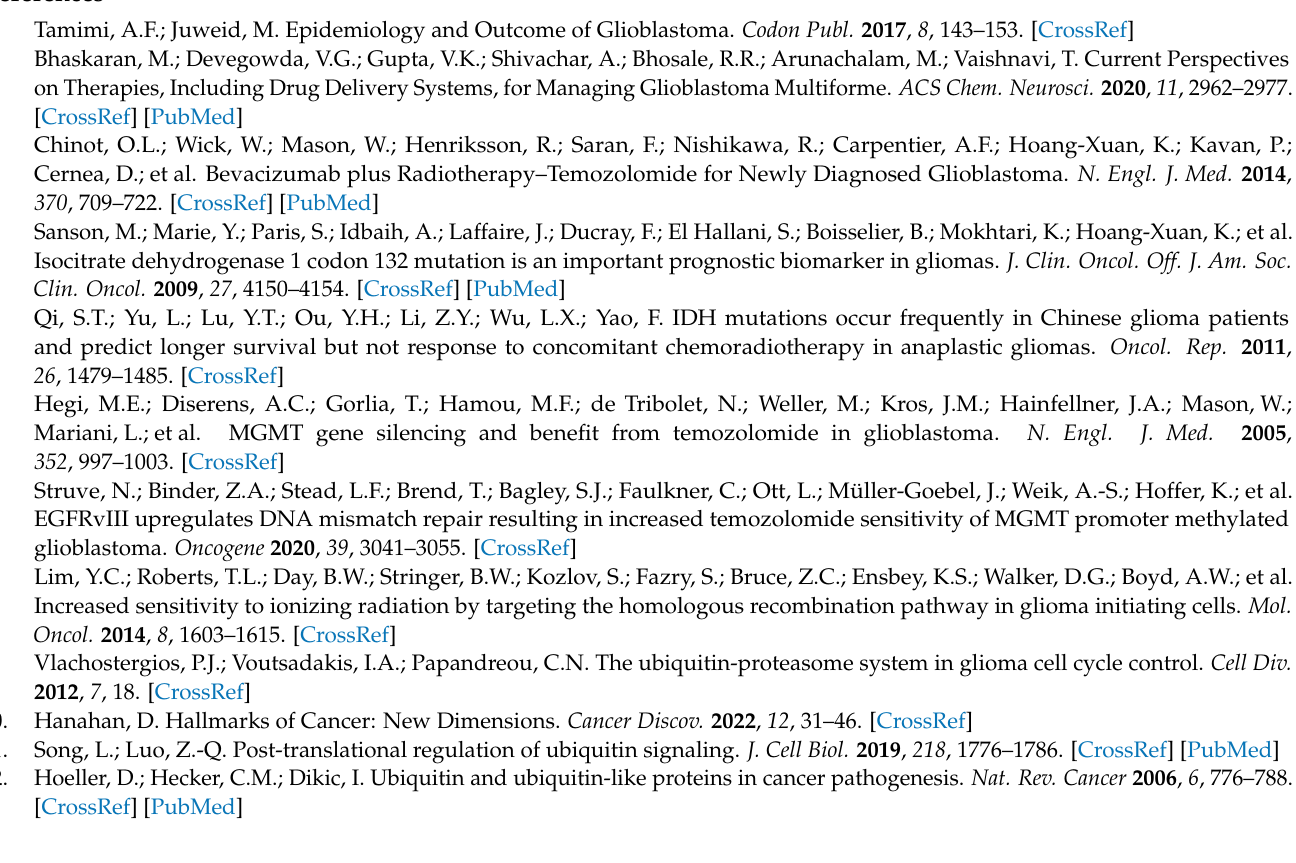
Supplementary Figure S1: Representative staining of USP6L and control in glioma FFPE tissue